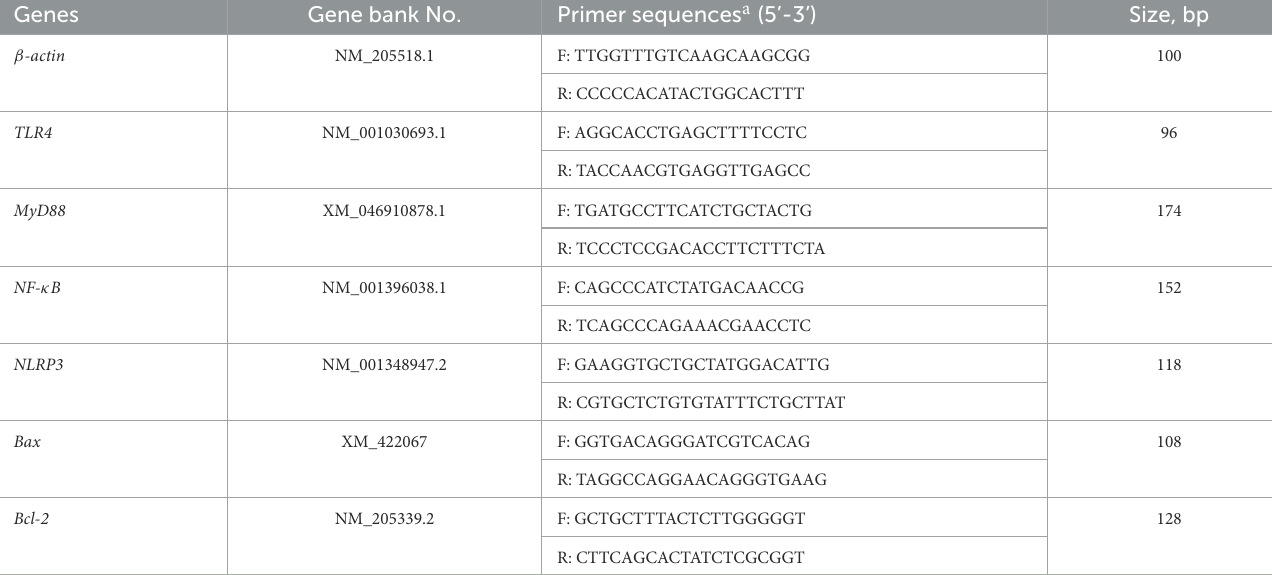
TABLE 2 Primer sequences used for quantitative real-time PCR. Genes Gene bank No. Primer sequences a (5’-3’) Size,